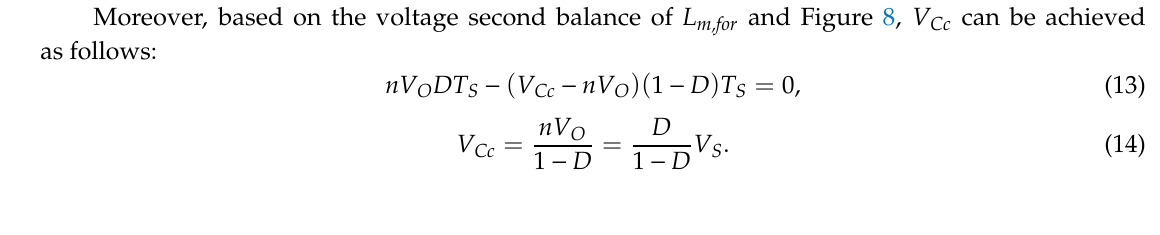
Figure 8. Applied voltage on L m,for and L m,fly of the proposed converter.